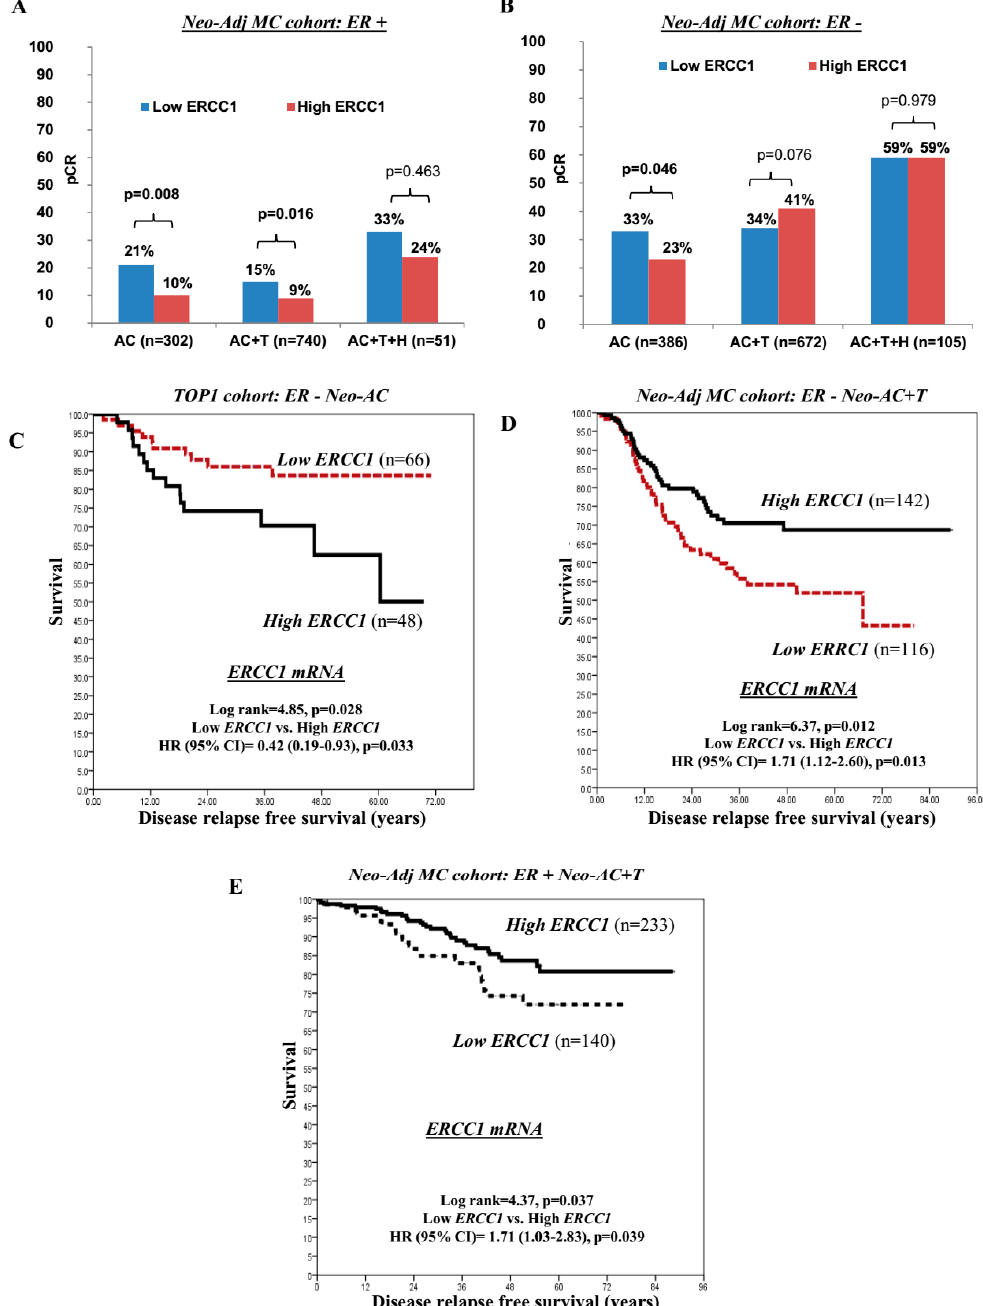
Figure 2. ERCC1 and neoadjuvant chemotherapy. ( A ) Pathological complete response (pCR) based on ERCC1 mRNA expression in ER + tumours (neoadjuvant anthracycline based (Neo-Adj) MC cohort) that received neoadjuvant AC or AC + T or AC + T + H chemotherapy. ( B ) Pathological complete response (pCR) based on ERCC1 mRNA expression in ER − tumours (Neo-Adj MC cohort) who received neoadjuvant AC or AC + T or AC + T + H chemotherapy. ( C ) Disease free survival based on ERCC1 mRNA expression in TOP1 cohort patients who received neoadjuvant AC chemotherapy. ( D ) Disease free survival based in ER − Neo-Adj MC cohort who received neoadjuvant AC + T chemotherapy. ( E ) Disease free survival based in ER + Neo-Adj MC cohort who received neoadjuvant AC + T